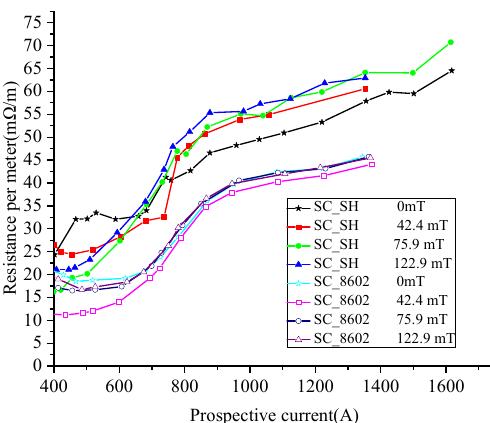
Figure 7. The relationship between the prospective current and the quenched resistance per meter of the testing tapes. Table 2. Distribution of Rising Rate of Quenched Resistance.